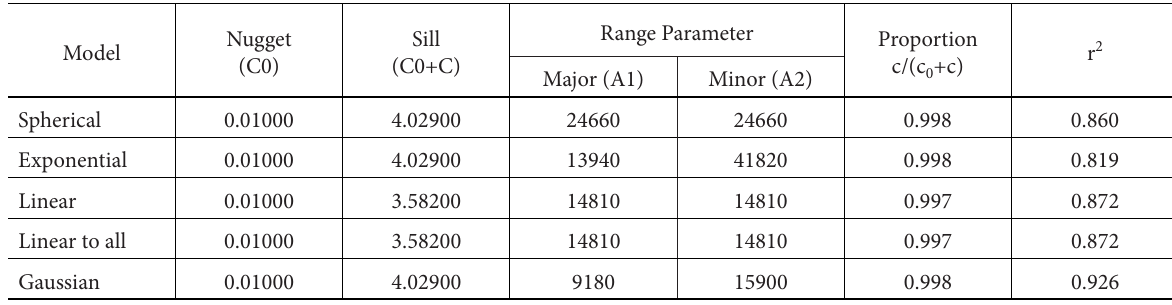
Table 2. Comparison of results from different model